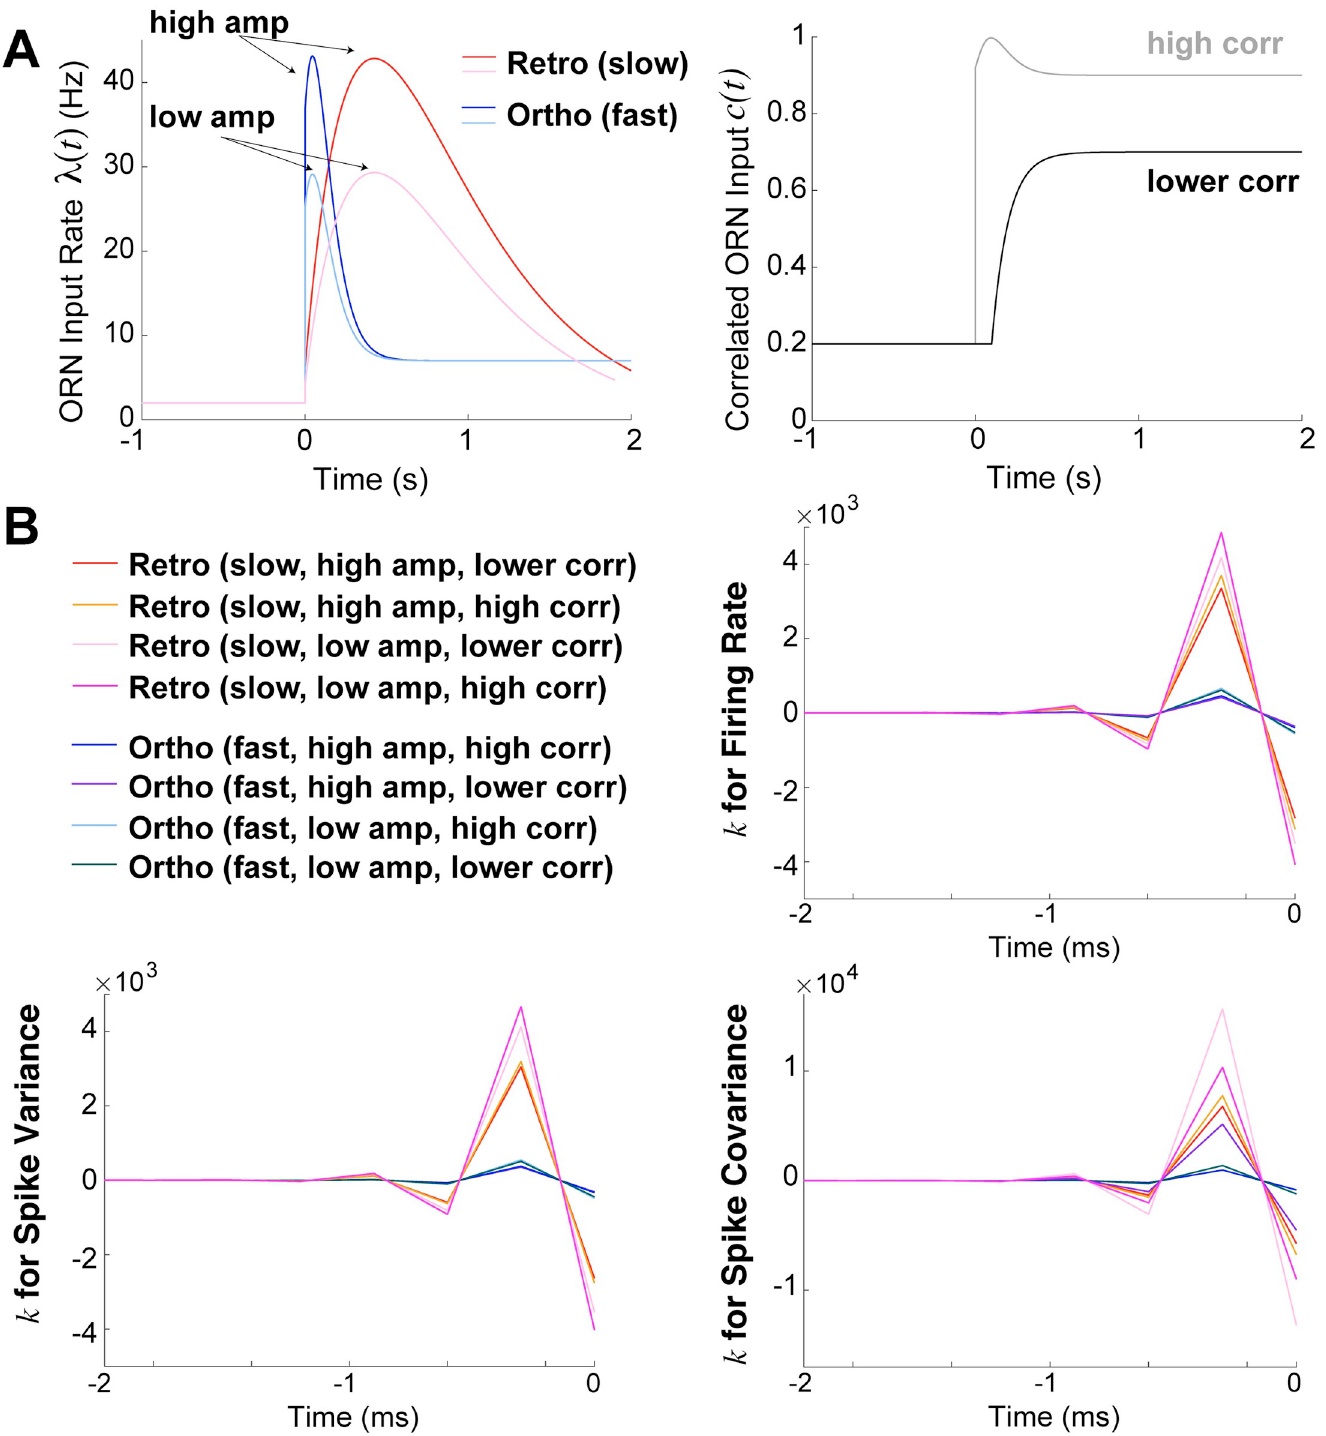
Fig 6. Temporal profile is crucial for larger magnitude filters. A ) Different combinations of input rates (left) including slower increase and decay (retro-like) and faster increase and decay (ortho-like) as well as high and low amplitude as labelled. Two different input correlations (right), with high correlation in gray, and lower correlation in black. B ) Resulting linear filters k ( t ) have consistently larger absolute values when temporal profile of ORN inputs is slower (retro-like), compared to faster (ortho-like).